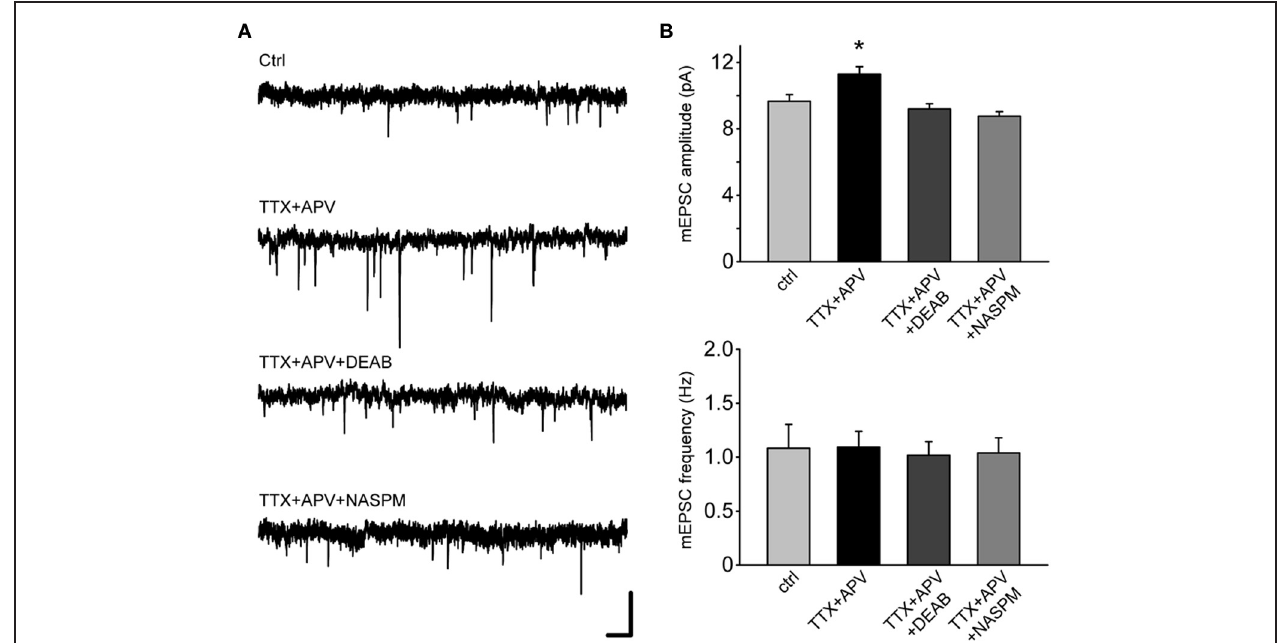
was bath applied during mEPSCs recording. Scale bars: 10pA, 0.5s. (B) mEPSCs amplitude and frequency analysis of (A) . Amplitude: ctrl: 9 . 65 ± 0 . 40pA; TTX + APV: 11 . 29 ± 0 . 45pA; TTX + APV +